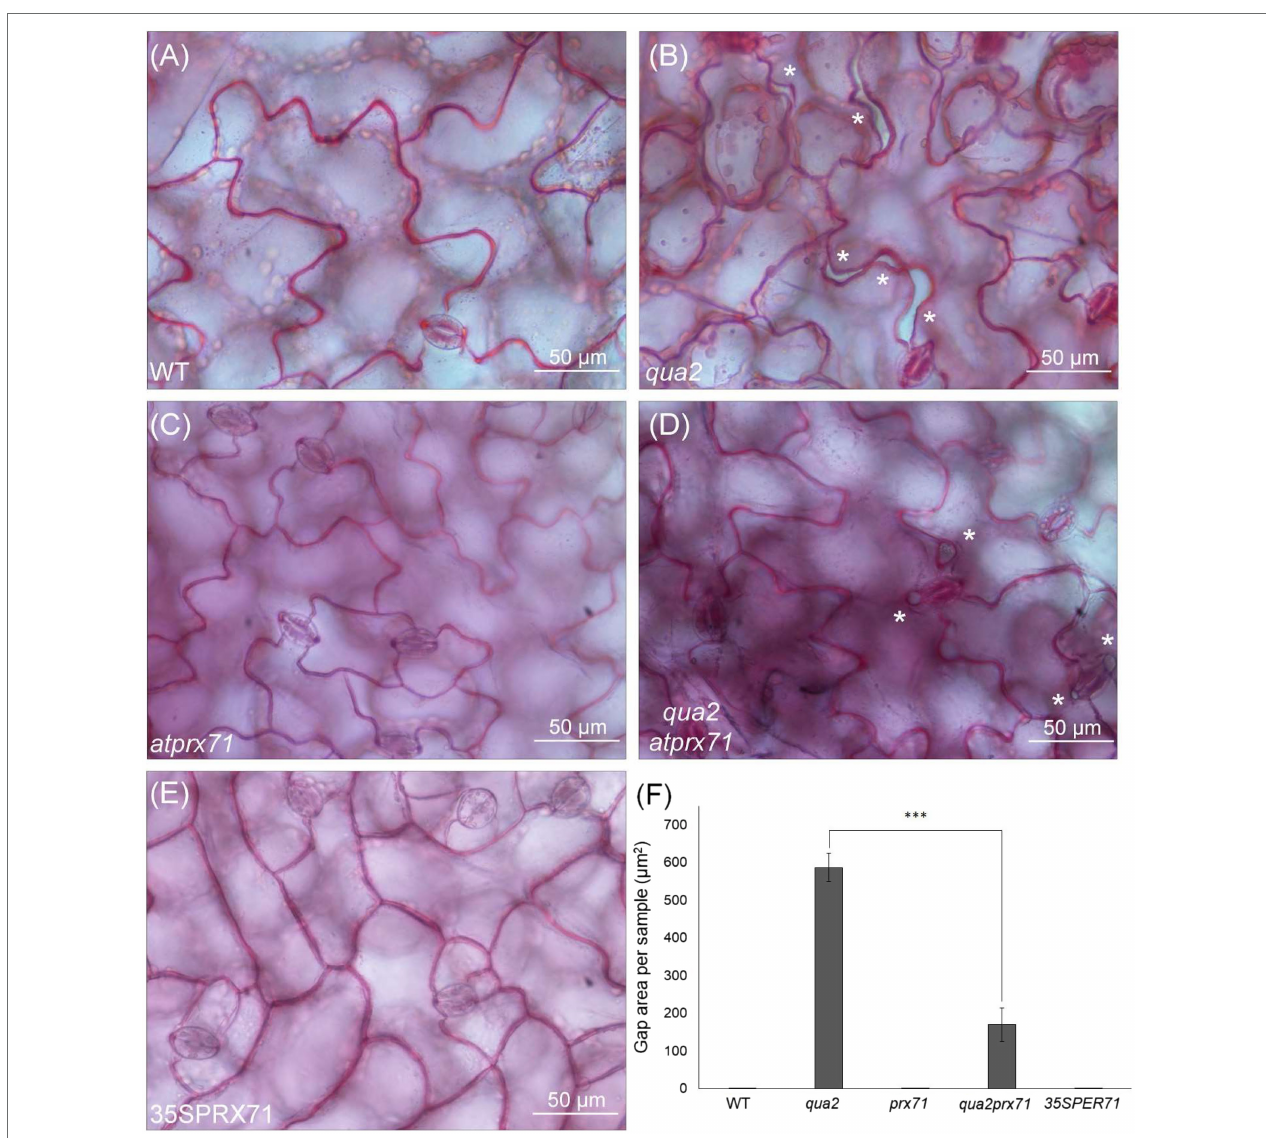
FIGURE 5 | Cell-adhesion defects in qua2 leaves are suppressed by loss of AtPRX71 . Rosette leaves of five-week-old Col-0 (WT) (A) , qua2 (B) , atprx71 (C) , qua2 atprx71 (D) , and 35S::AtPRX71 #22 (35SPRX71) (E) plants were stained with ruthenium red and epidermal cells of the adaxial face were photographed. Asterisks indicate gaps between adjacent cells. (A–E) , Representative images of at least five images per genotype. (F) , For each experiment, total area of the gaps between adjacent cells per image was analyzed (total area of images = 60,000 μ m 2 ). Bars indicate average gap area ± SD ( n = 3). Asterisks indicate statistically significant difference between qua2 and qua2 atprx71 , according to Student’s t-test ( *** p <